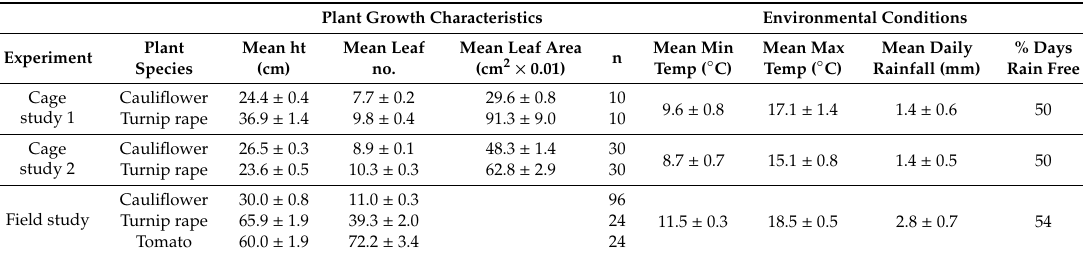
Table 1. Plant growth characteristics and summary of environmental conditions for the three experiments conducted. All plant measurements were taken at the end of experiments. ht = height; no. = number; n = number of plants measured; min = minimum; max = maximum; temp = temperature. Leaf areas were assessed using a Delta T bench-top leaf area